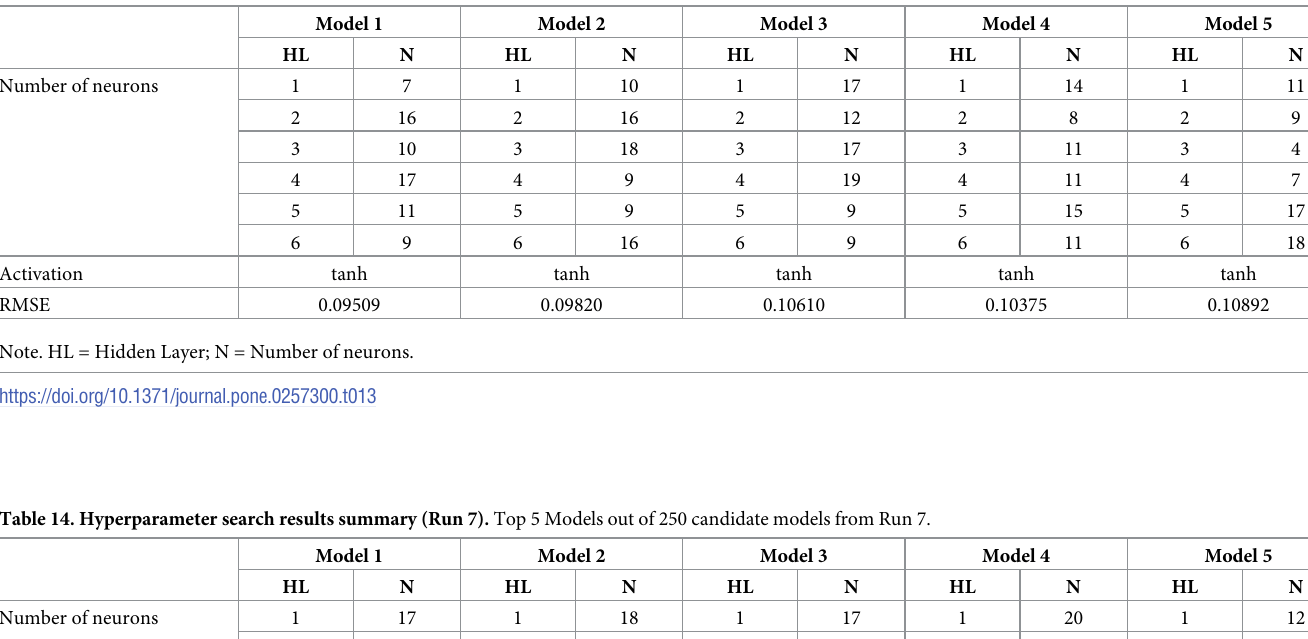
Table 13. Hyperparameter search results summary (Run 6). Top 5 Models out of 250 candidate models from Run 6.